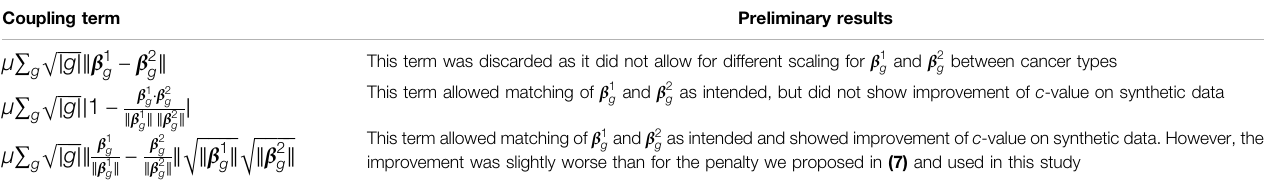
TABLE 1 | Alternative coupling penalty terms that were given preliminary investigation using synthetic data. Coupling